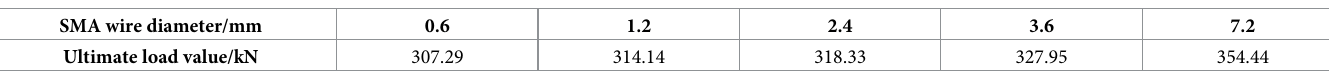
Table 14. Ultimate load values of reinforcement parts with different diameter of SMA